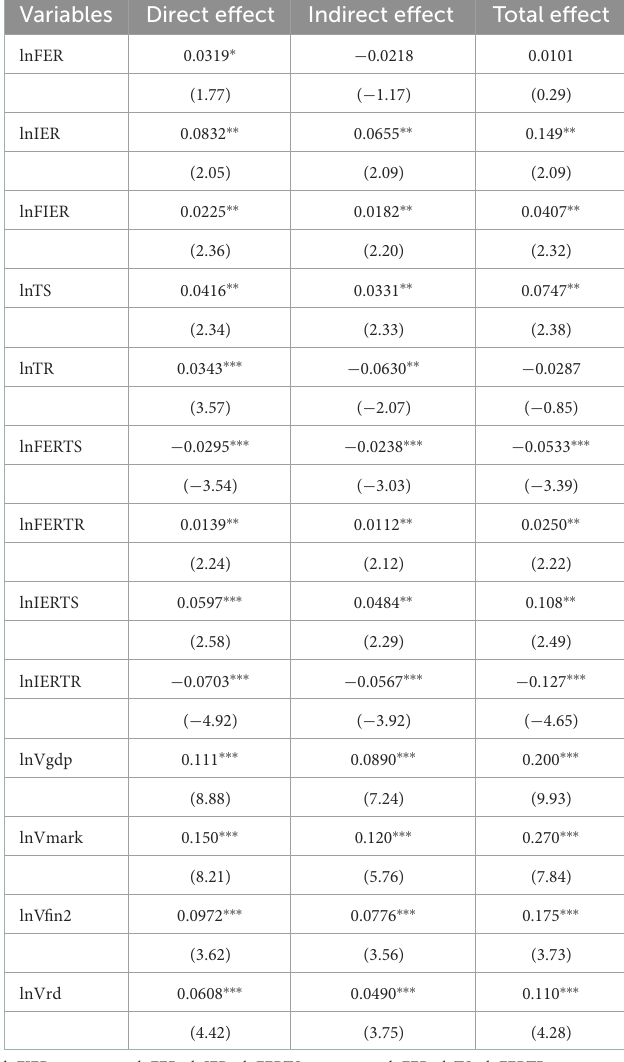
TABLE 6 Spatial effects decomposition